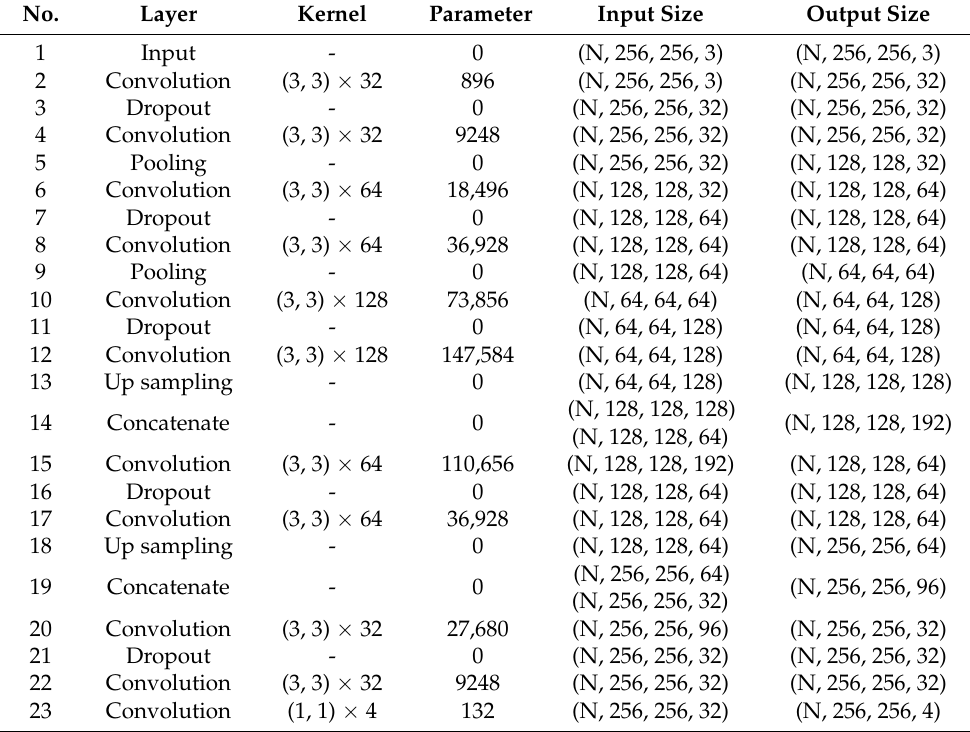
Table 2. The detailed specifications of the